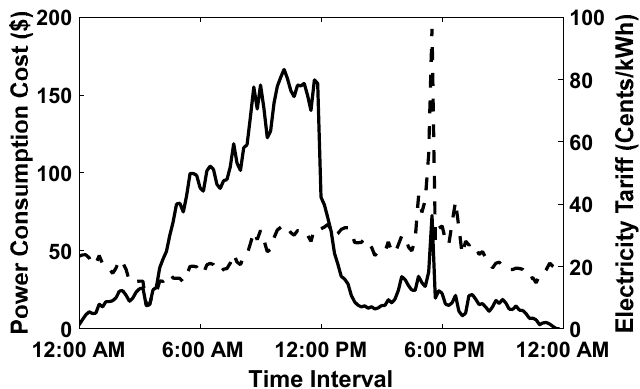
Figure 5. Power Consumption Cost and Electricity Tariff in 24 h, when 𝐸 = 500 .